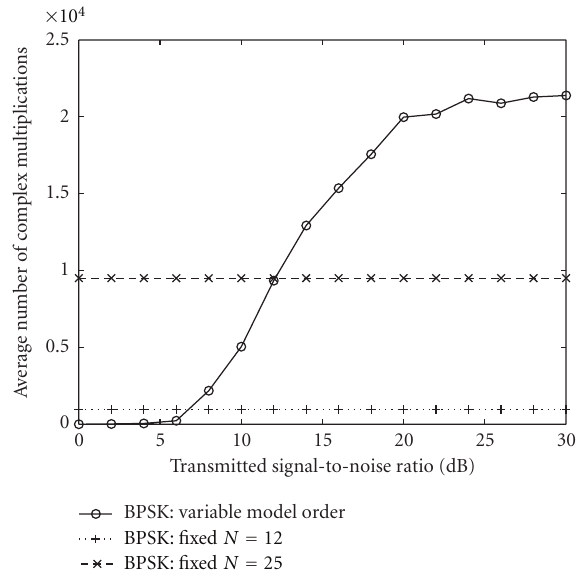
Figure 7: The corresponding computational complexities to Figure 5 versus signal-to-noise ratio (the threshold for our variable model scheme is τ J = 1 /